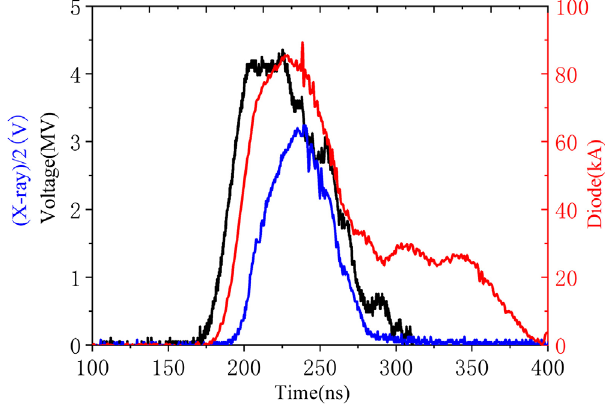
FIG. 7. Typical output voltage (black), diode current (red), and x-ray signals (blue) from shot 19-054. The Marx generators were charged to (cid:1) 60 kV for this shot.